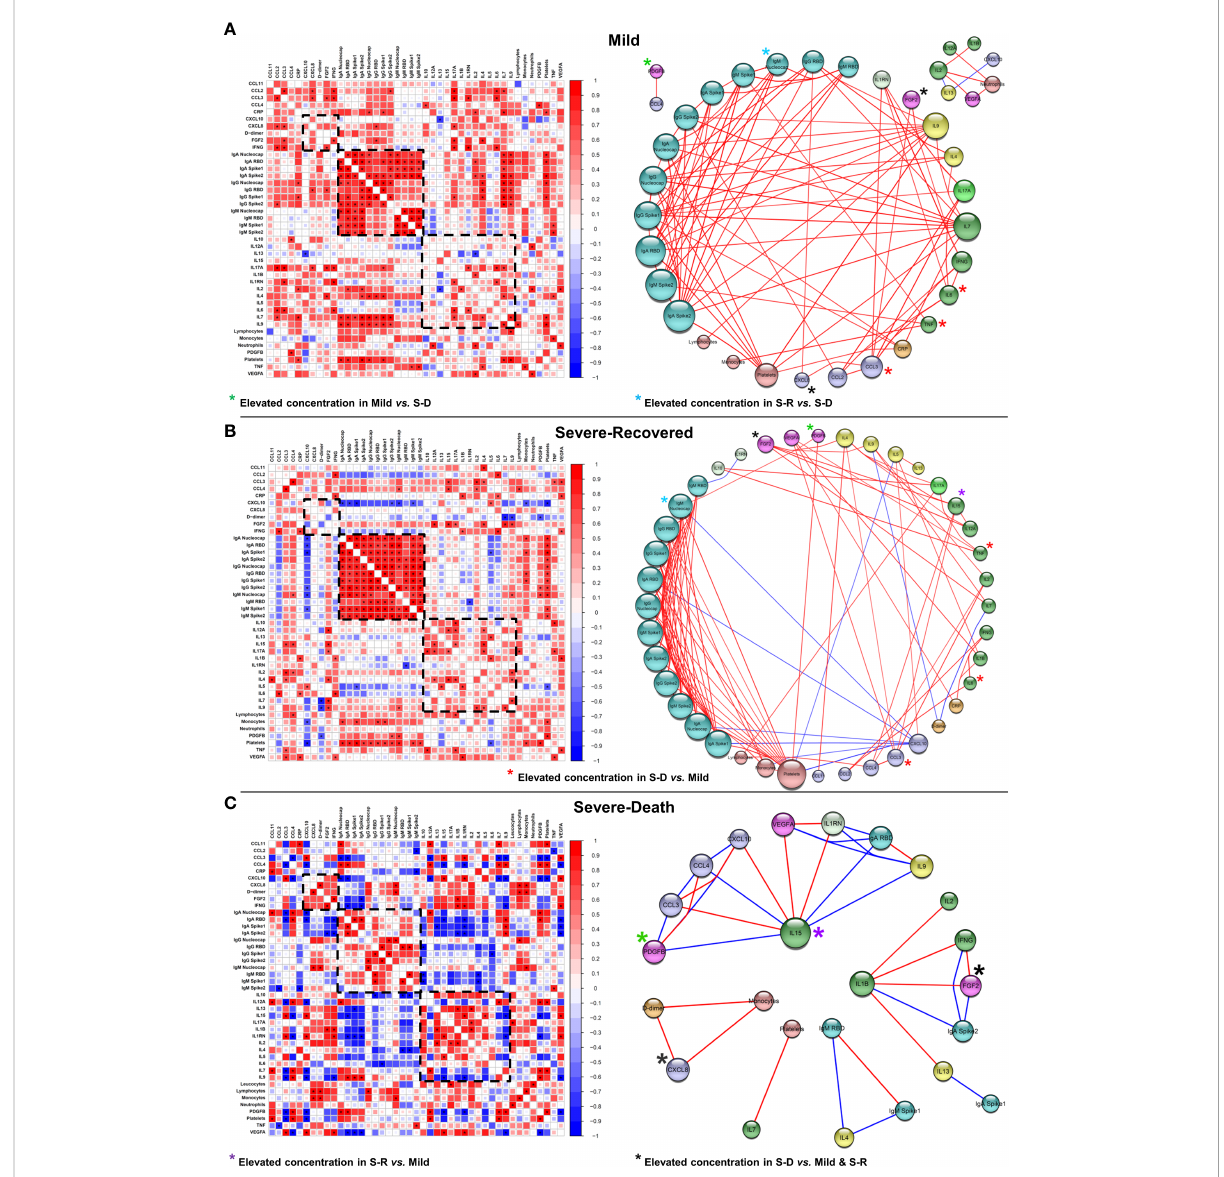
FIGURE 7 Correlation networks suggest lack of immune regulation and loss of coordinated antibody production in patients with solid tumors that went on to die from COVID-19. Data from electronic health records, 27-Plex assay and anti-SARS-CoV-2 proteins ’ antibodies assays was used to construct a Spearman ’ s correlation matrix with all statistically signi fi cant ( p < 0.05, highlighted as *) Spearman ’ s Rho values, ranging from -1 to 1. The matrix was then used to construct the correlation networks. Red lines connecting the spheres represent positive correlations, whereas line thickness and hotter colors represent correlations with Rho closer to 1. Blue lines connecting the spheres represent negative correlations, whereas line thickness and colder colors represent correlations with Rho closer to -1. Spheres ’ sizes correlate with the number of interactions for each factor, whereas the bigger radius represents factors with more interactions. Spheres ’ colors represent factors that have similar activities, characteristics or functions. Disease groups were de fi ned as Mild ( A ; n = 8), Severe-Recovered ( B ; n = 9) and Severe-Death ( C ; n = 5), as described. Nucleocapsid, RBD, Spike 1 and Spike 2 labels refers to antibodies anti-SARS-CoV-2 proteins. Lymphocytes, Monocytes, Neutrophils and Platelets refers to blood counts per mm³ of blood. CRP, C-Reactive Protein; FGF2, Fibroblast Growth Factor 2; IL-1RN, Interleukin 1 Receptor Antagonist; RBD, Receptor Binding